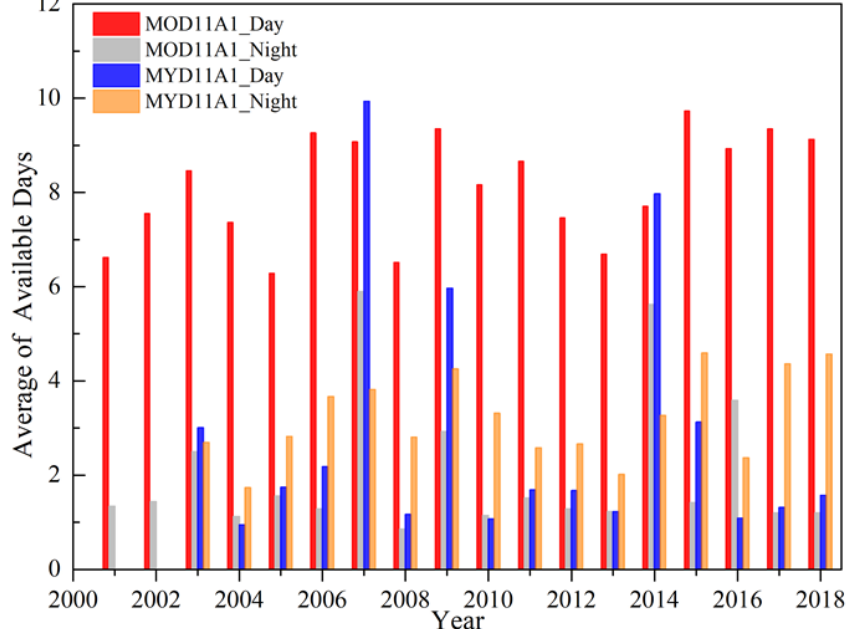
Figure 2. Monthly average (DJF) of the available days of MOD11A1_Day (red), MOD11A1_Night (grey), MYD11A1_Day (blue), and MYD11A1_Night data (orange) over the Purog Kangri ice field from 2001 to 2018 after quality control.